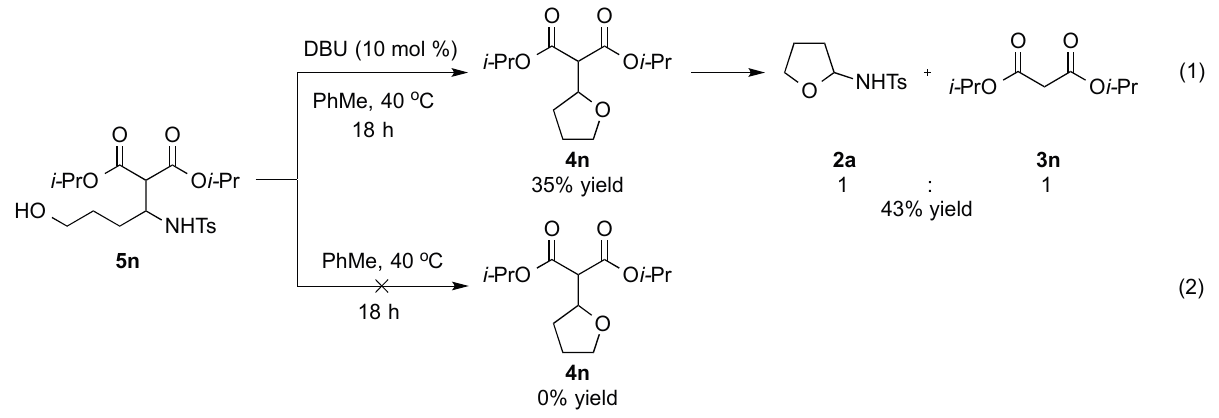
Figure 2. ORTEP drawing for 5n with thermal ellipsoids at 50% probability level [119].